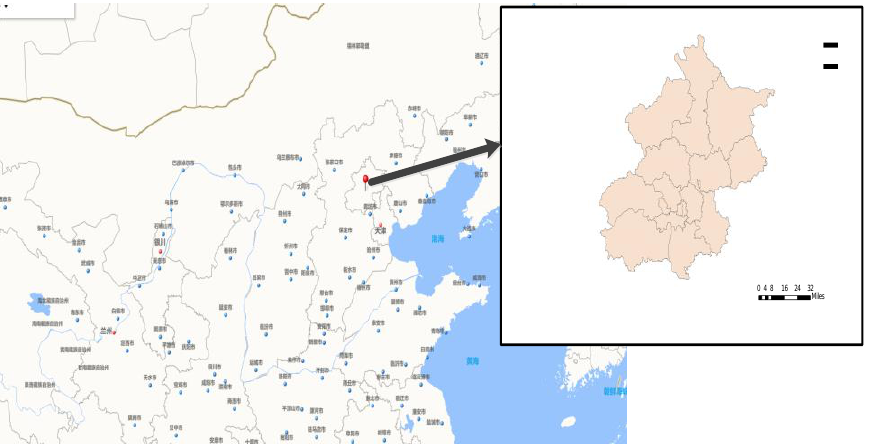
Figure 5. The location of the research zone.